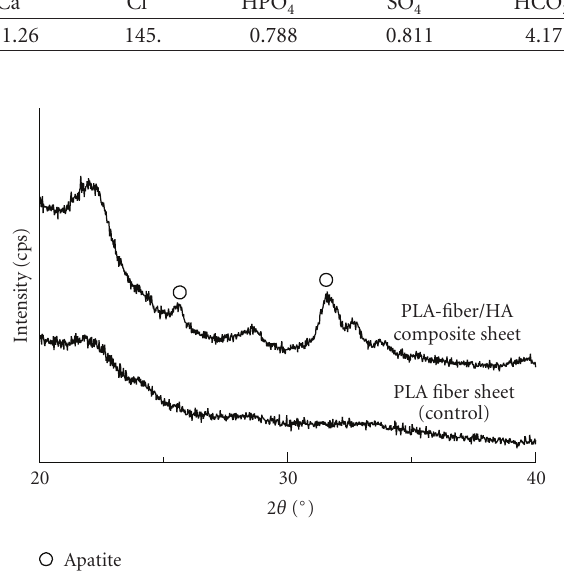
Figure 4: TF-XRD patterns of the PLA-fiber/HA composite sheet and PLA-fiber sheet. The spectrum of the PLA-fiber/HA composite sheet exhibits apatite peaks at 2 θ values of 25.56 ◦ and 31.60 ◦